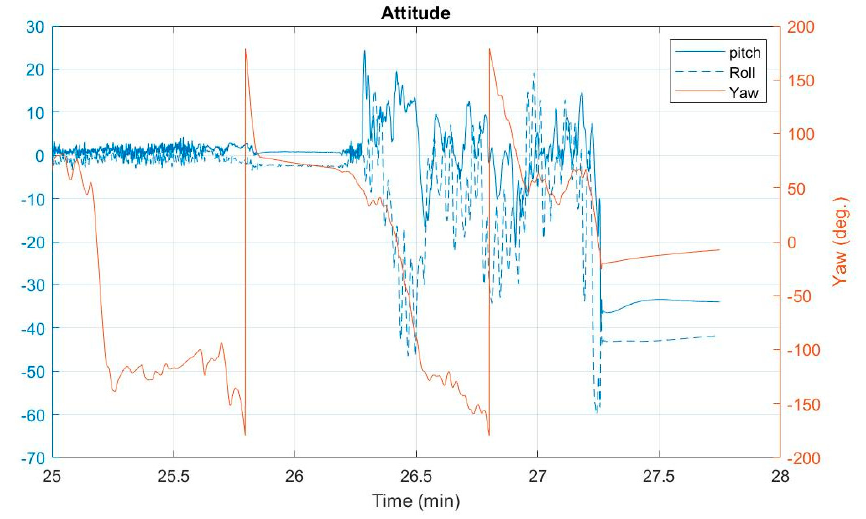
Figure 16. Attitude in the first round of the second flight test (time = 25–28 s).